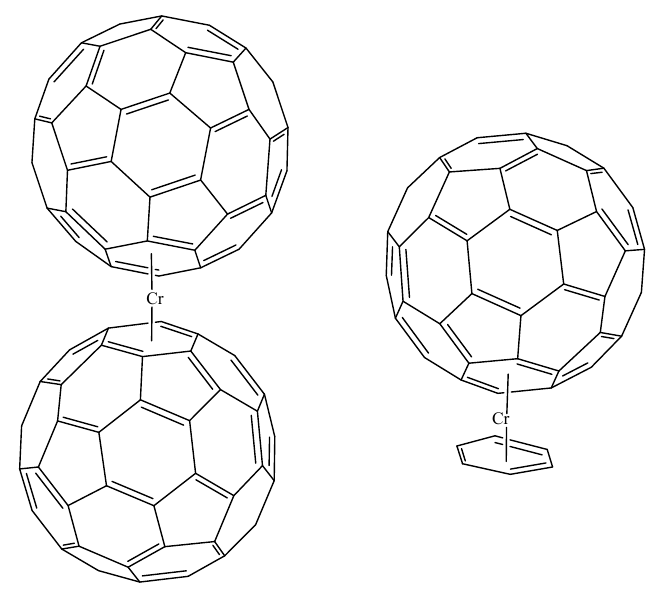
Figure 15. The six isomers of C